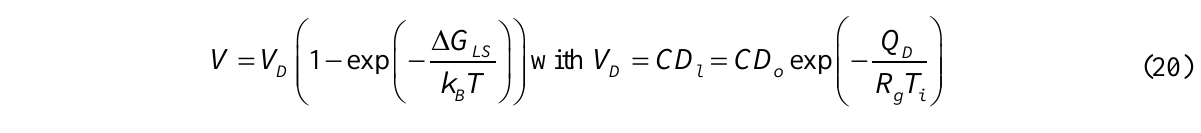
equals to the t